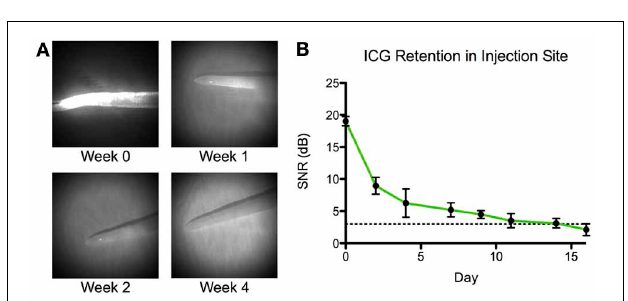
FIGURE 5 | ICG is retained in tissue space for 2 weeks. (A) Representative images of the tip of a rat tail at four time points: immediately following ICG injection (week 0) and 1, 2, and 4 weeks after injection. (B) Average signal-to-noise ratio (SNR) of ICG in the tip of the rat tail ( n = 4). Dotted line represents limit of detection at 3dB. Error bars represent standard